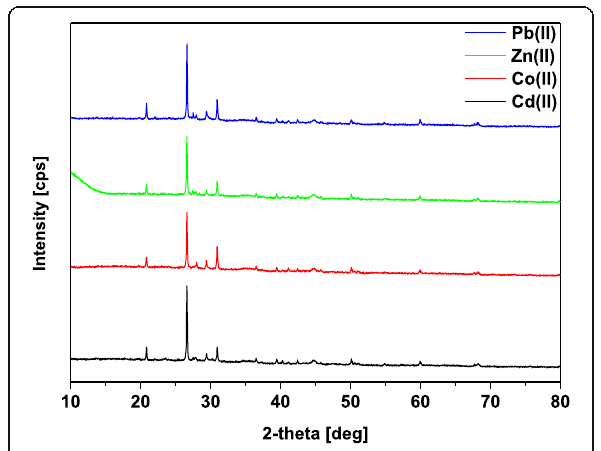
Fig. 7 XRD analysis of MBC2 after Cd(II), Co(II), Zn(II) and Pb(II) ion sorption